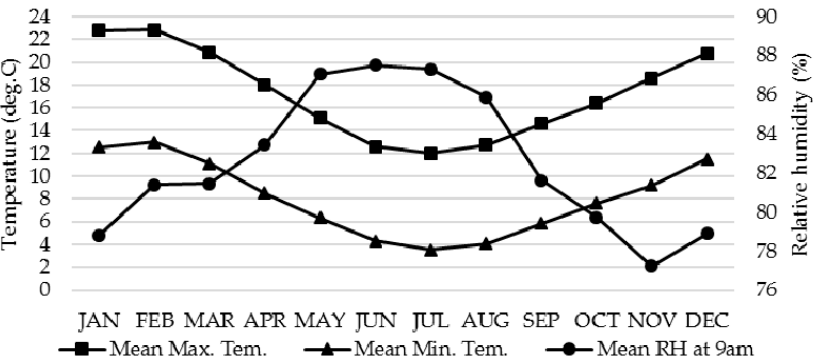
Figure 1. Climate data of Rotorua (Source: NIWA, the National Institute of Water and Atmospheric Research).